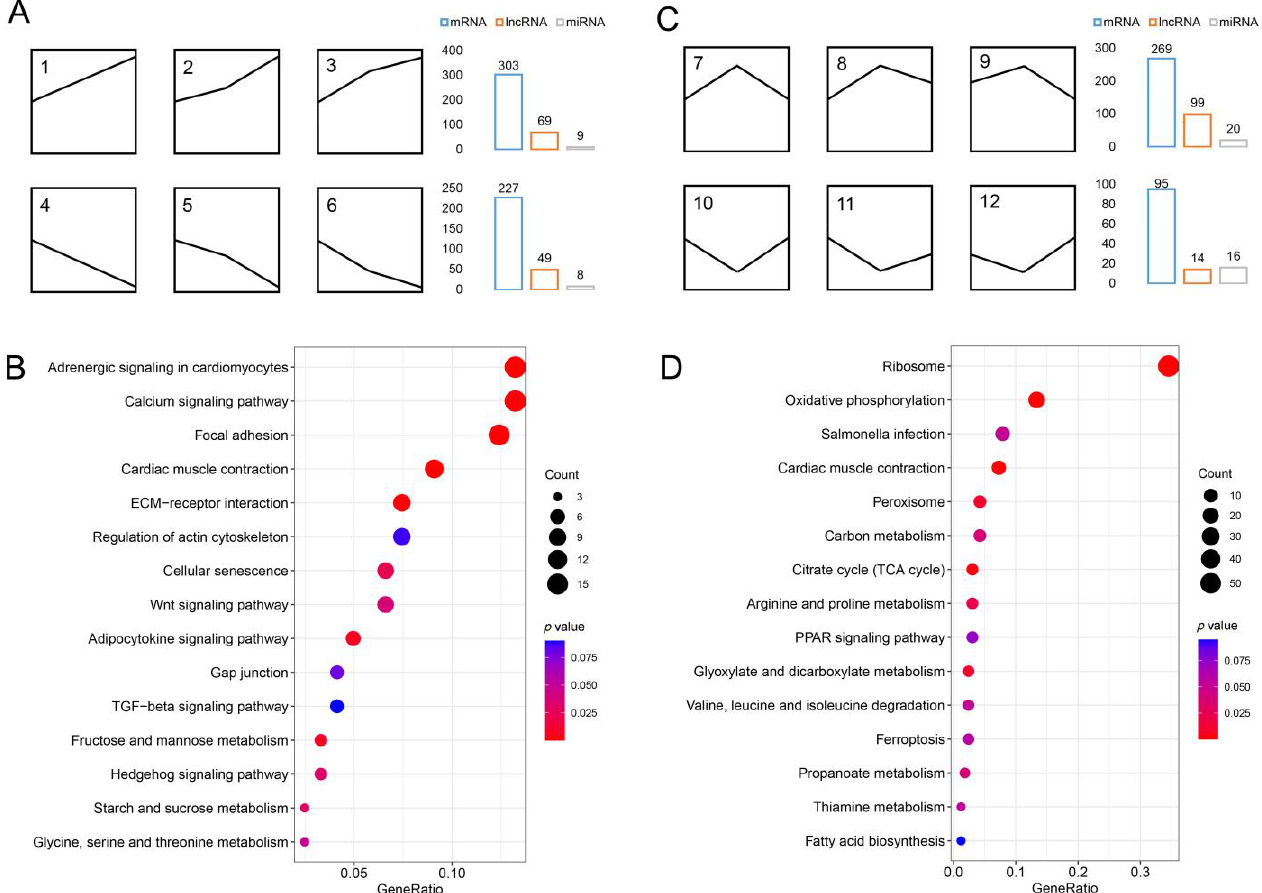
Figure 3. Identification of mRNA, lncRNA, and miRNA associated with the development and formation of IBs. ( A ) Six gene expression patterns were associated with IB development: 1, 2, and 3, were upregulated, and 4, 5, and 6 were downregulated. ( B ) The top 15 pathways from KEGG enrichment results of DEmRNAs were associated with the growth of IBs. ( C ) Six gene expression patterns were associated with the formation of IBs: 7, 8, and 9, were upregulated, whereas 10, 11, and 12 were down-regulated. ( D ) The top 15 pathways from KEGG enrichment results of DEmRNAs were associated with the formation of IBs. Table 1. The DEmRNAs in known pathways associated with bone development.